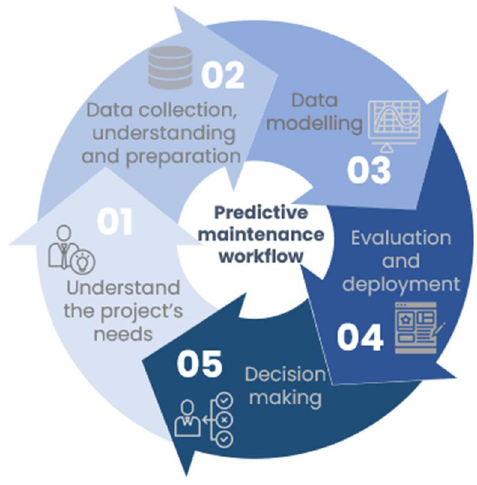
Figure 8. Workflow of predictive maintenance.